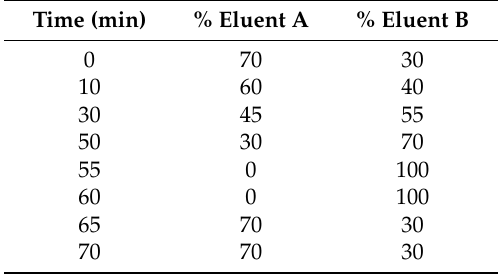
Table 3. The elution method used for the RP-HPLC-PDA-ESI-MSn analysis to determine the polyphenol content in the variety of samples. The eluent A is 0.1% formic acid while eluent B is 100%